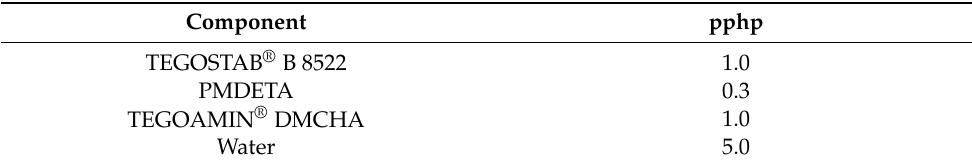
Table 2. PU additives used in the production of PU foams expressed in parts per 100 parts of polyol weight (pphp).